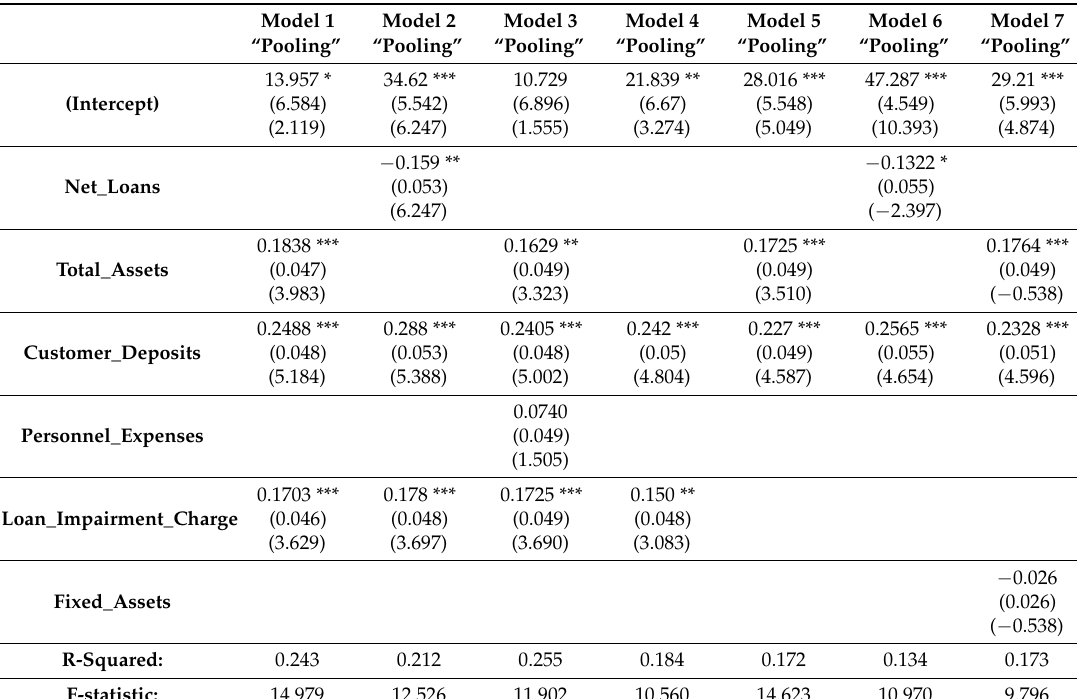
Table 7. Results of panel regression model for V4 countries (dependent variable